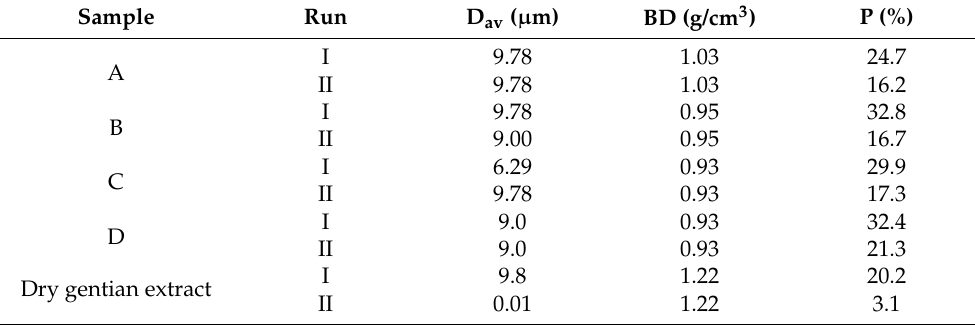
Table 4. Average pore diameter, bulk density, and porosity of powders A–D (solid lipid microparti- cles) and dry gentian extract. Sample